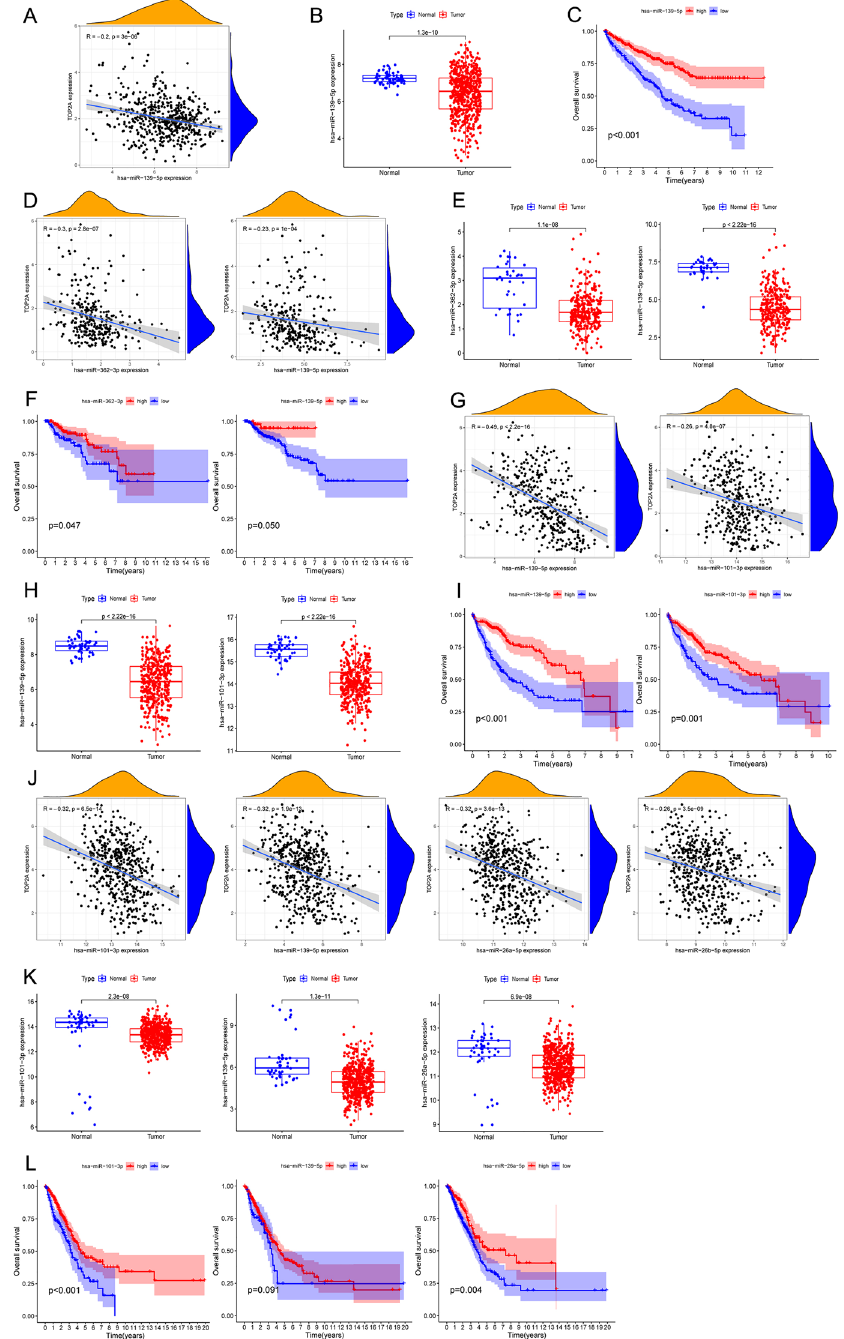
Figure 5. Predictive analysis of upstream miRNA of TOP2A. All miRNA expression was shown as log2(miRNA + 1). ( A ) The negative correlation between miR-139-5p and TOP2A in KIRC. ( B ) The expression of miR-139-5p in KIRC and normal tissues. ( C ) Overall survival analysis based on miR-139-5p expression in KIRC. ( D )The negative correlation between miRNAs (miR-362-3p and miR-139-5p) and TOP2A in KIRP. ( E ) The expression of miRNAs (miR-362-3p and miR-139-5p) in KIRP and normal tissues. ( F ) Overall survival analysis based on expression of miRNAs (miR-362-3p and miR-139-5p) in KIRP. ( G ) The negative correlation between miRNAs (miR-139-5p and miR-101-3p) and TOP2A in LIHC. ( H ) The expression of miRNAs (miR- 139-5p and miR-101-3p) in LIHC and normal tissues. ( I ) Overall survival analysis based on expression of miRNAs (miR-139-5p and miR-101-3p) in LIHC. ( J ) The negative correlation between miRNAs (miR-101-3p, miR-139-5p, miR-26a-5p, miR-26b-5p) and TOP2A in LUAD. ( K ) The expression of miRNAs (miR-101-3p, miR-139-5p and miR-26a-5p) in LUAD and normal tissues. ( L ) Overall survival analysis based on expression of miRNAs miR-101-3p, miR-139-5p and miR-26a-5p) in